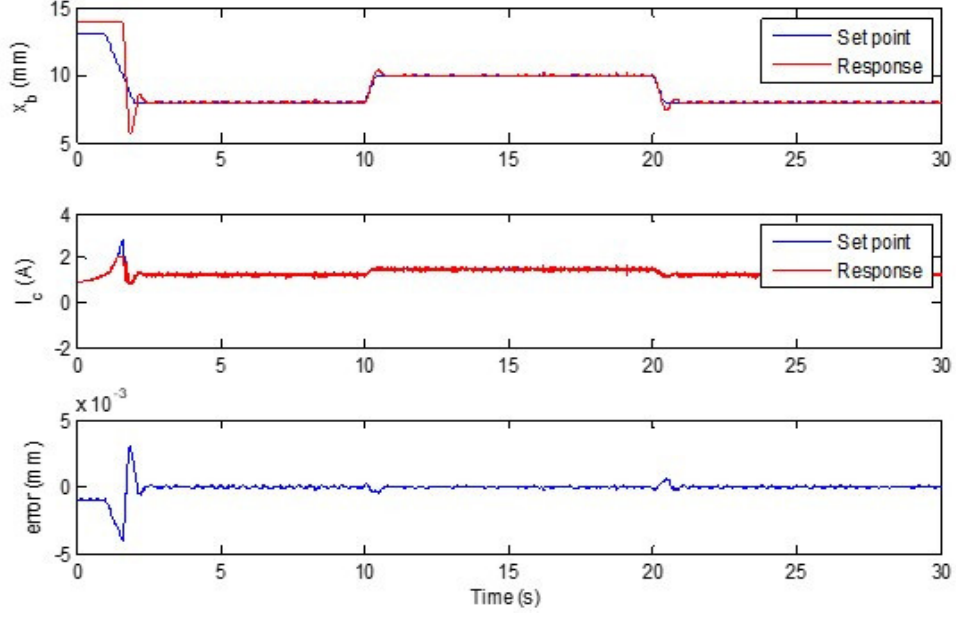
Figure 8. Symmetric tracking pattern.